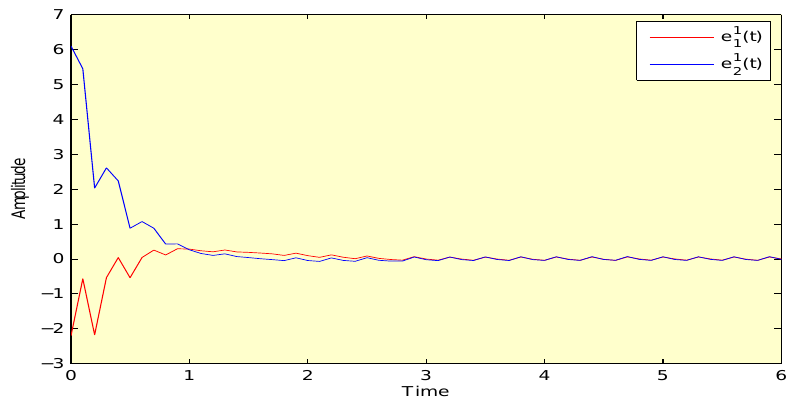
( t ) , (cid:101) 1 ( t ) of NN model (11) under con- 2 1